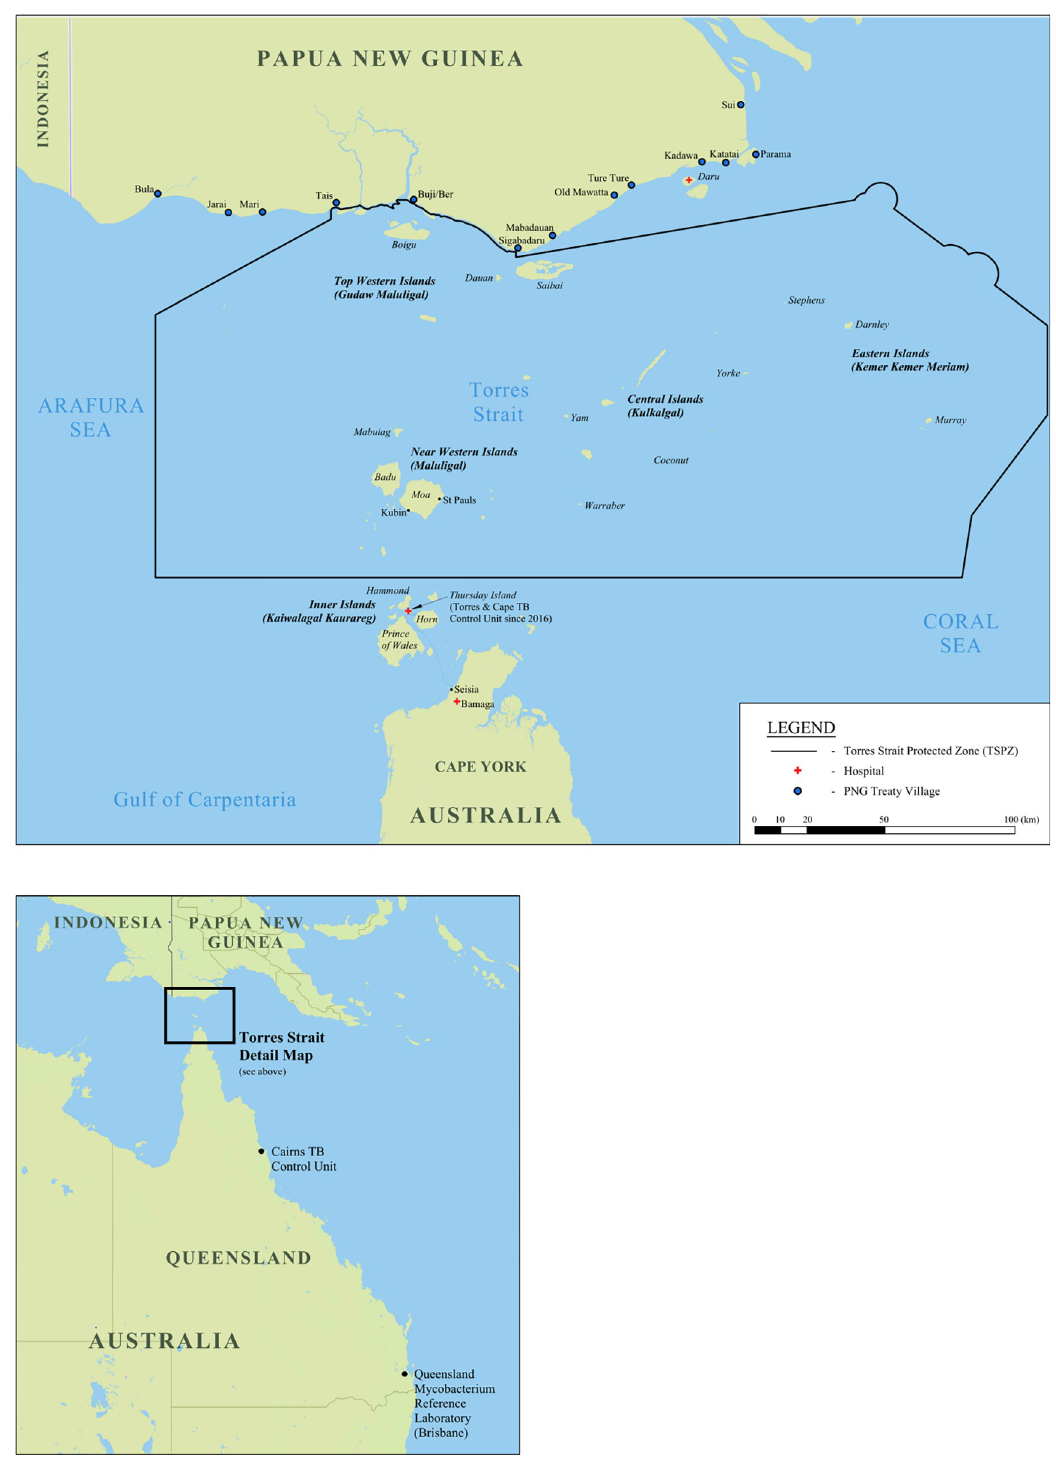
Fig 1. Map of the Torres Strait / Papua New Guinea cross-border region [16] 1 CC BY 4.0. 1 International travel without passport or visa is permitted for traditional inhabitants of the Torres Strait Protected Zone and Treaty villages of Papua New Guinea, DOI. 10.6084/m9.figshare.16632823.